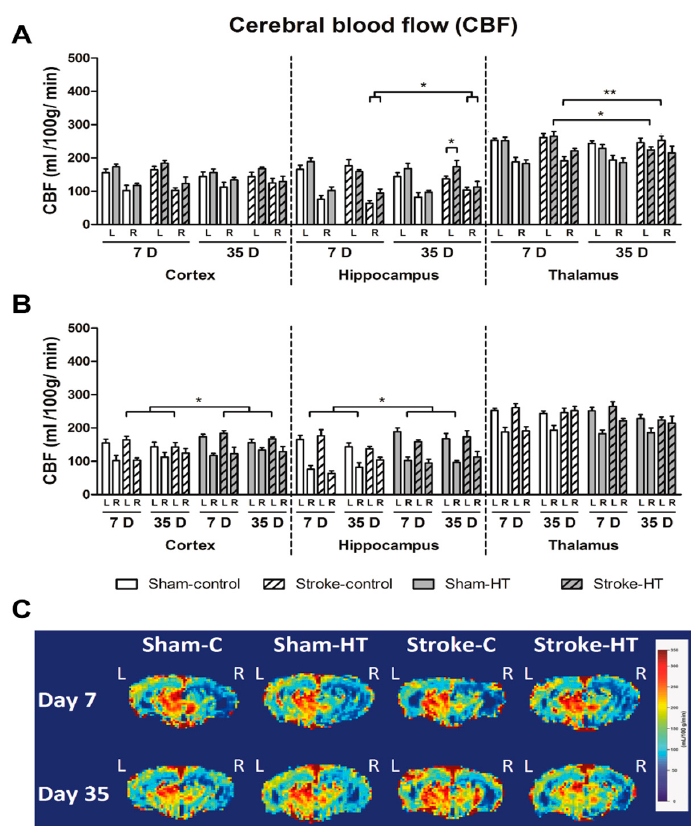
Figure 10. CBF was assessed in the lesioned and unlesioned hemisphere at seven and 35 days post- stroke in the hippocampus, thalamus, and cortex. At seven days post-stroke, cerebral blood flow (CBF) was lower in all groups in the right cortex (Sham-control: p < 0.002; Sham-HT: p < 0.004; Stroke- control: p < 0.007; Stroke-HT: p < 0.024), right hippocampus (Sham-control: p < 0.003; Sham-HT: p